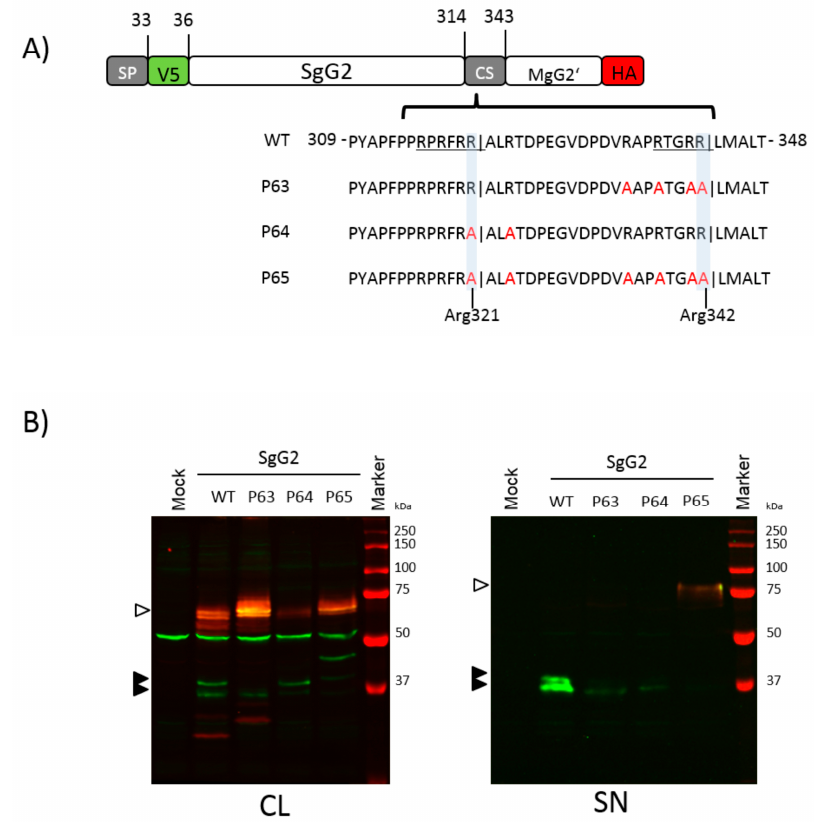
Figure 5. Mutations of Arg321 and Arg341 do not completely abrogate cleavage. ( A ) Schematic representation of SgG2 and derived constructs. The wild type CS sequence (amino acids 314–343) and mutated residues (in red) are shown. Underlined residues indicate potential furin motifs; vertical lines in sequence indicate proposed cleavage. ( B ) Western blots showing gG2 protein detected with anti V5 or HA antibodies in the cell lysate (CL, left blot) and supernatant (SN, right blot) of HEK-293T transfected cells. Black arrowhead indicates SgG2 cleavage products, and white arrowheads indicate precursor protein. One of four independent experiments is shown.